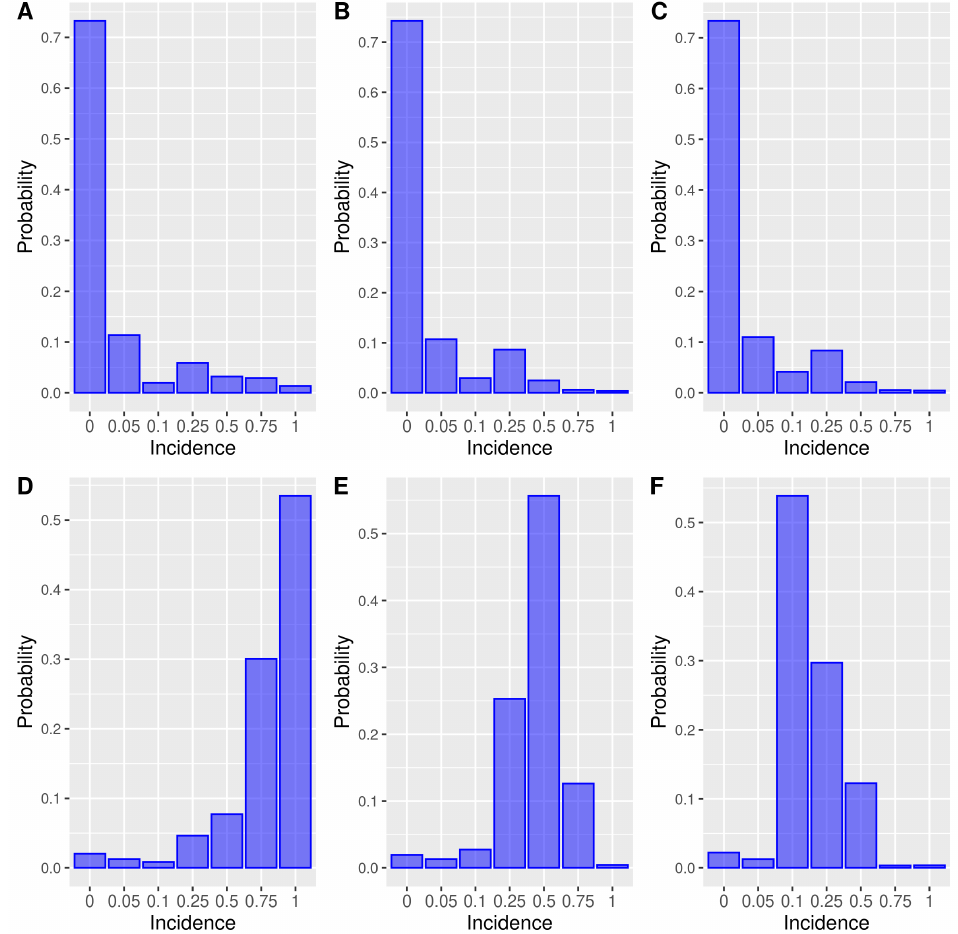
Figure 3. Probability distributions of each category of incidence for every quadruple ( c k , m , t , h ) s